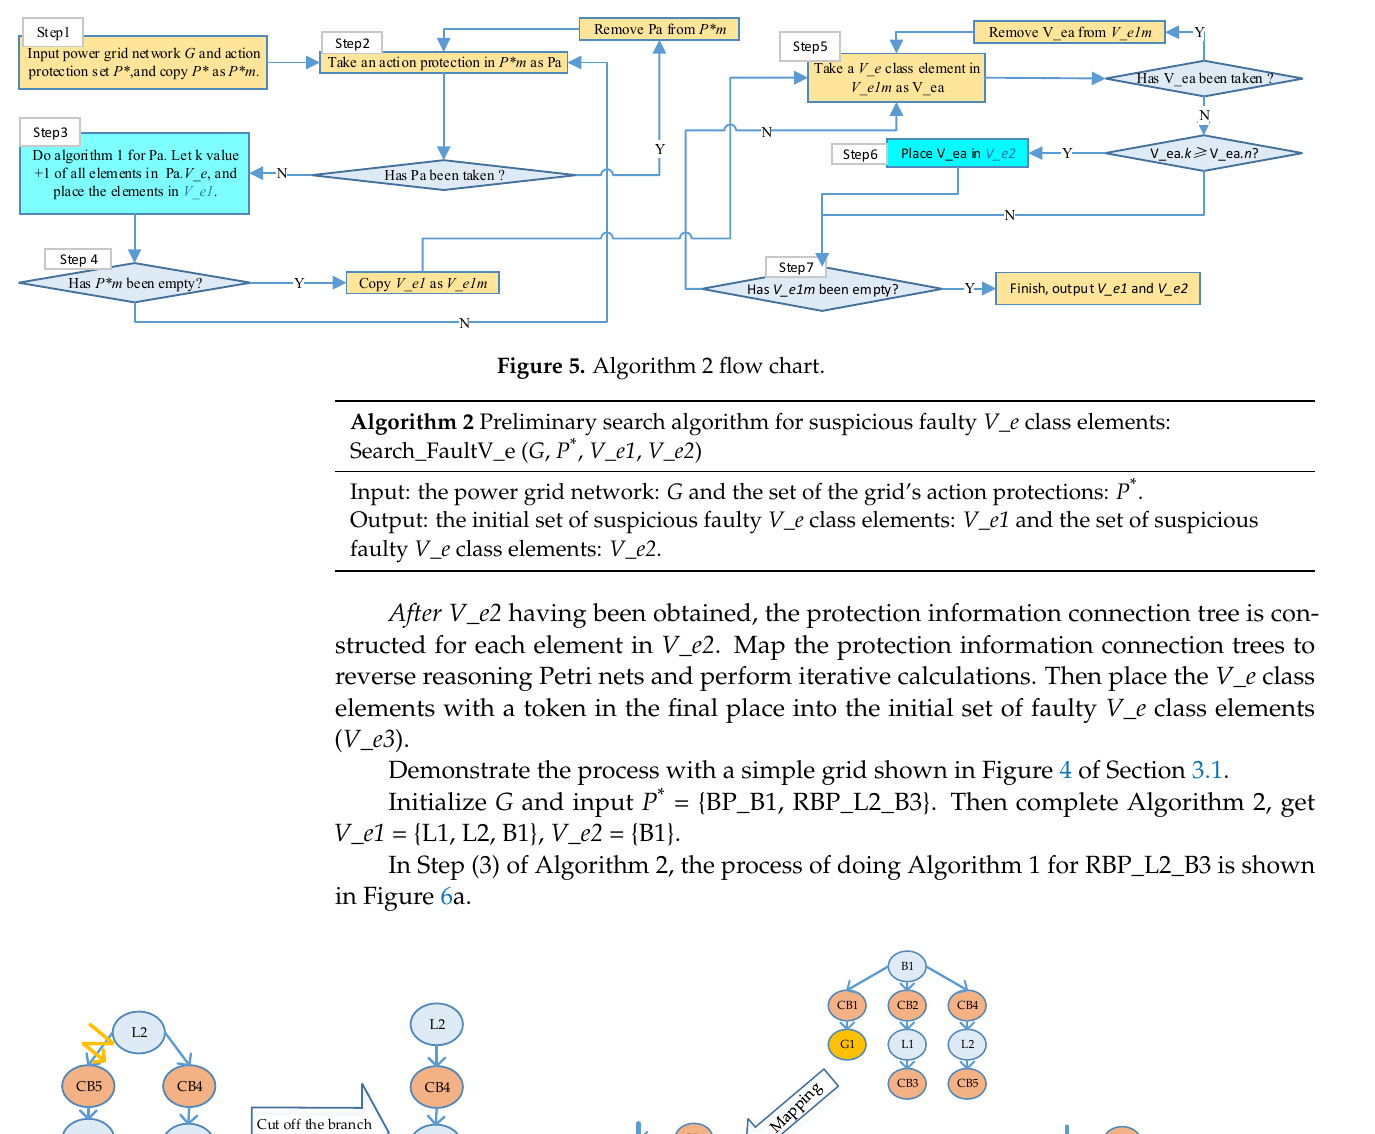
Algorithm 2 Preliminary search algorithm for suspicious faulty V_e class elements: